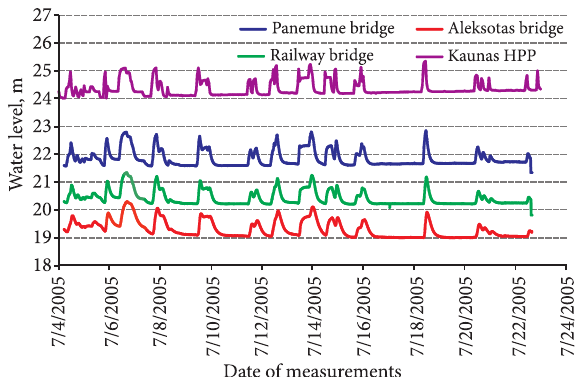
Fig. 2. Dynamics of water levels measured in the Nemunas